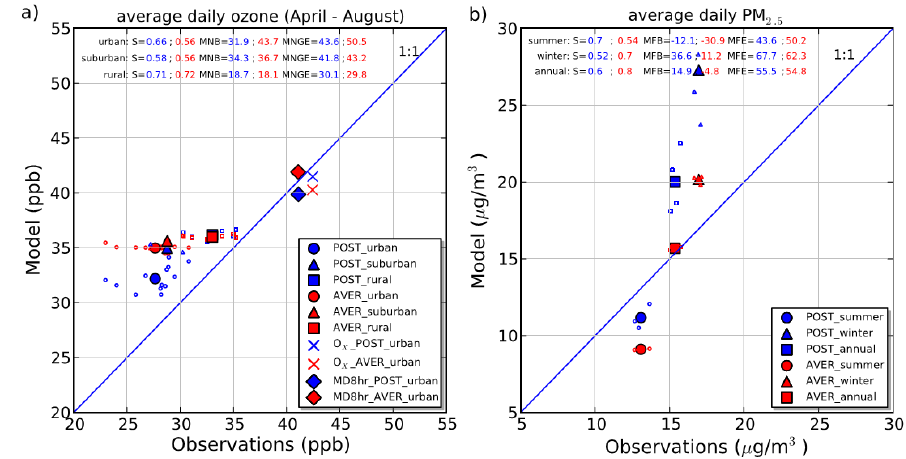
Figure 11. Scatter plots and scores for the sensitivity test on the resolution of the emission inventory for ozone and PM 2 . 5 .